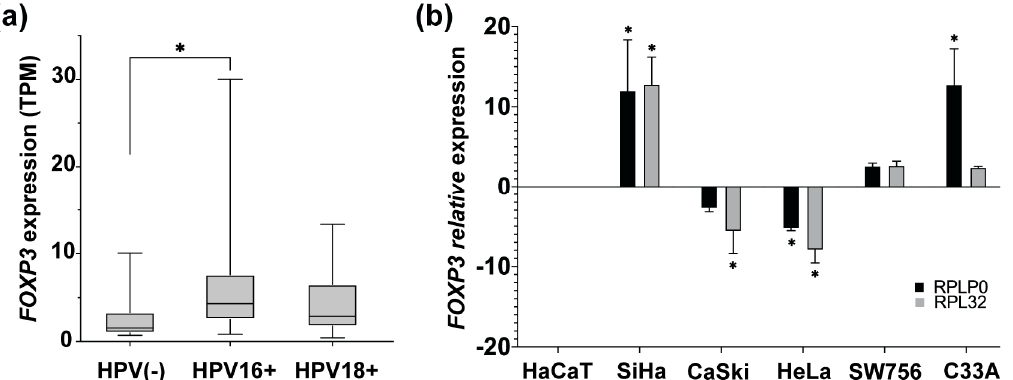
Figure 3. FOXP3 expression levels in cervical cancer samples and cervical cancer-derived cell lines. ( a ) Comparison of FOXP3 expression levels in transcript per million (TPM), from CC samples HPV16+ and HPV18+ vs. HPV(-) CC samples; ( b ) detection of FOXP3 relative expression levels by qPCR in CC-derived cell lines HPV16+ (SiHa and CaSki), HPV18+ (HeLa and SW756), and HPV(-) (C33A); RPLP0 and RPL32 were used as reference genes. The expression of FOXP3 in HaCaT cells was used as a calibrator. (*) depicts statistical significance with a p -value <